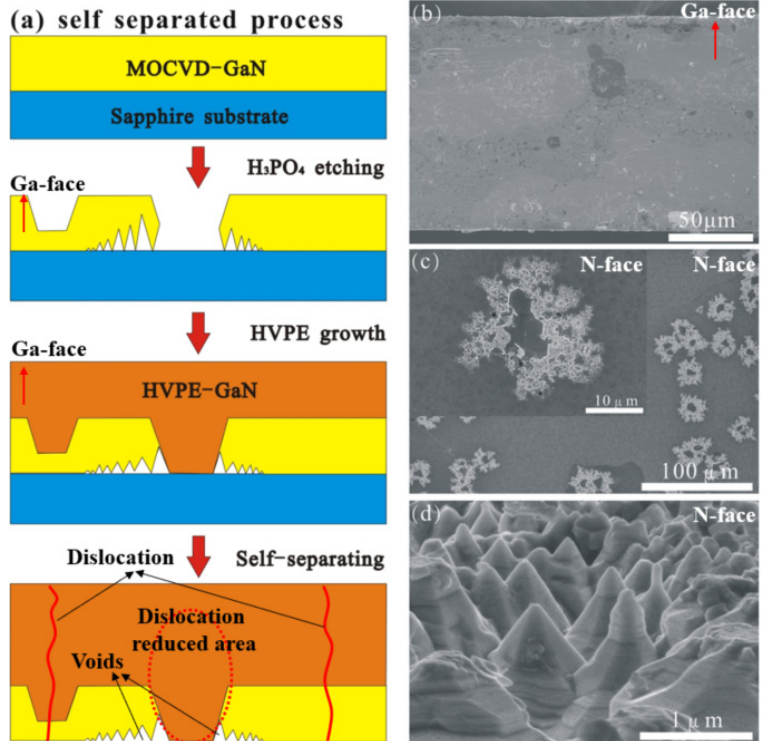
Figure 4. The schematic diagram of ( a ) the self-separating process. ( b ) Cross-section SEM image of the free-standing GaN crystal. ( c) SEM image of the free-standing hydride vapor phase epitaxy (HVPE)–GaN N-polar face. ( d ) After HVPE growth, the pyramids show six facets.